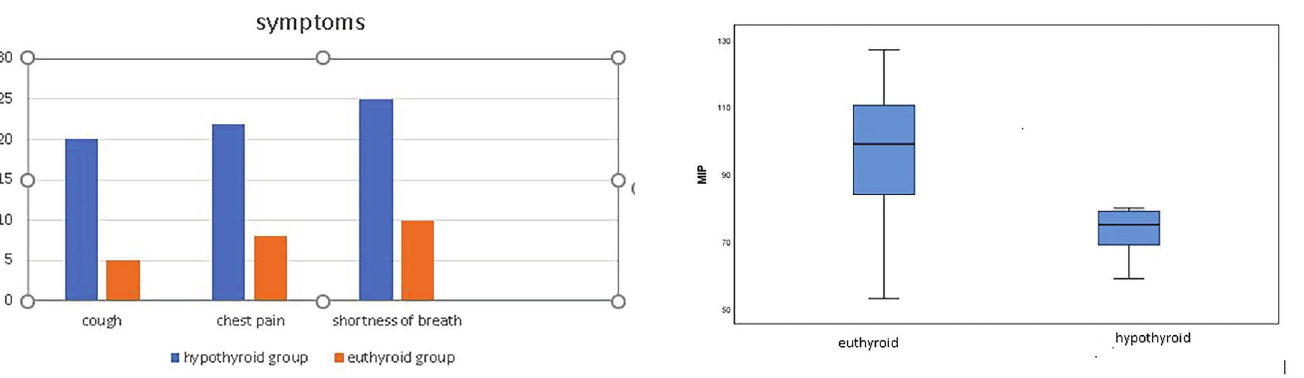
Figure 2 -Comparison of the MIP value of hypothyroid and